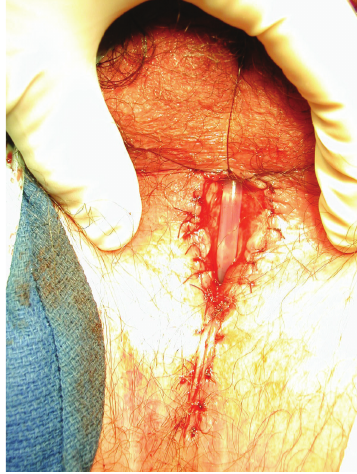
Figure 4: Perineal urethrostomy, performed using our suggested “side-to-side”